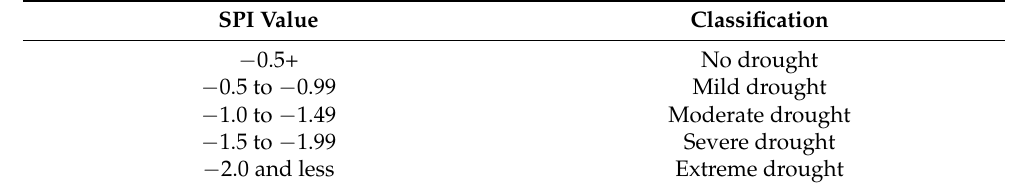
Table 1. Drought classification based on standardized precipitation index.